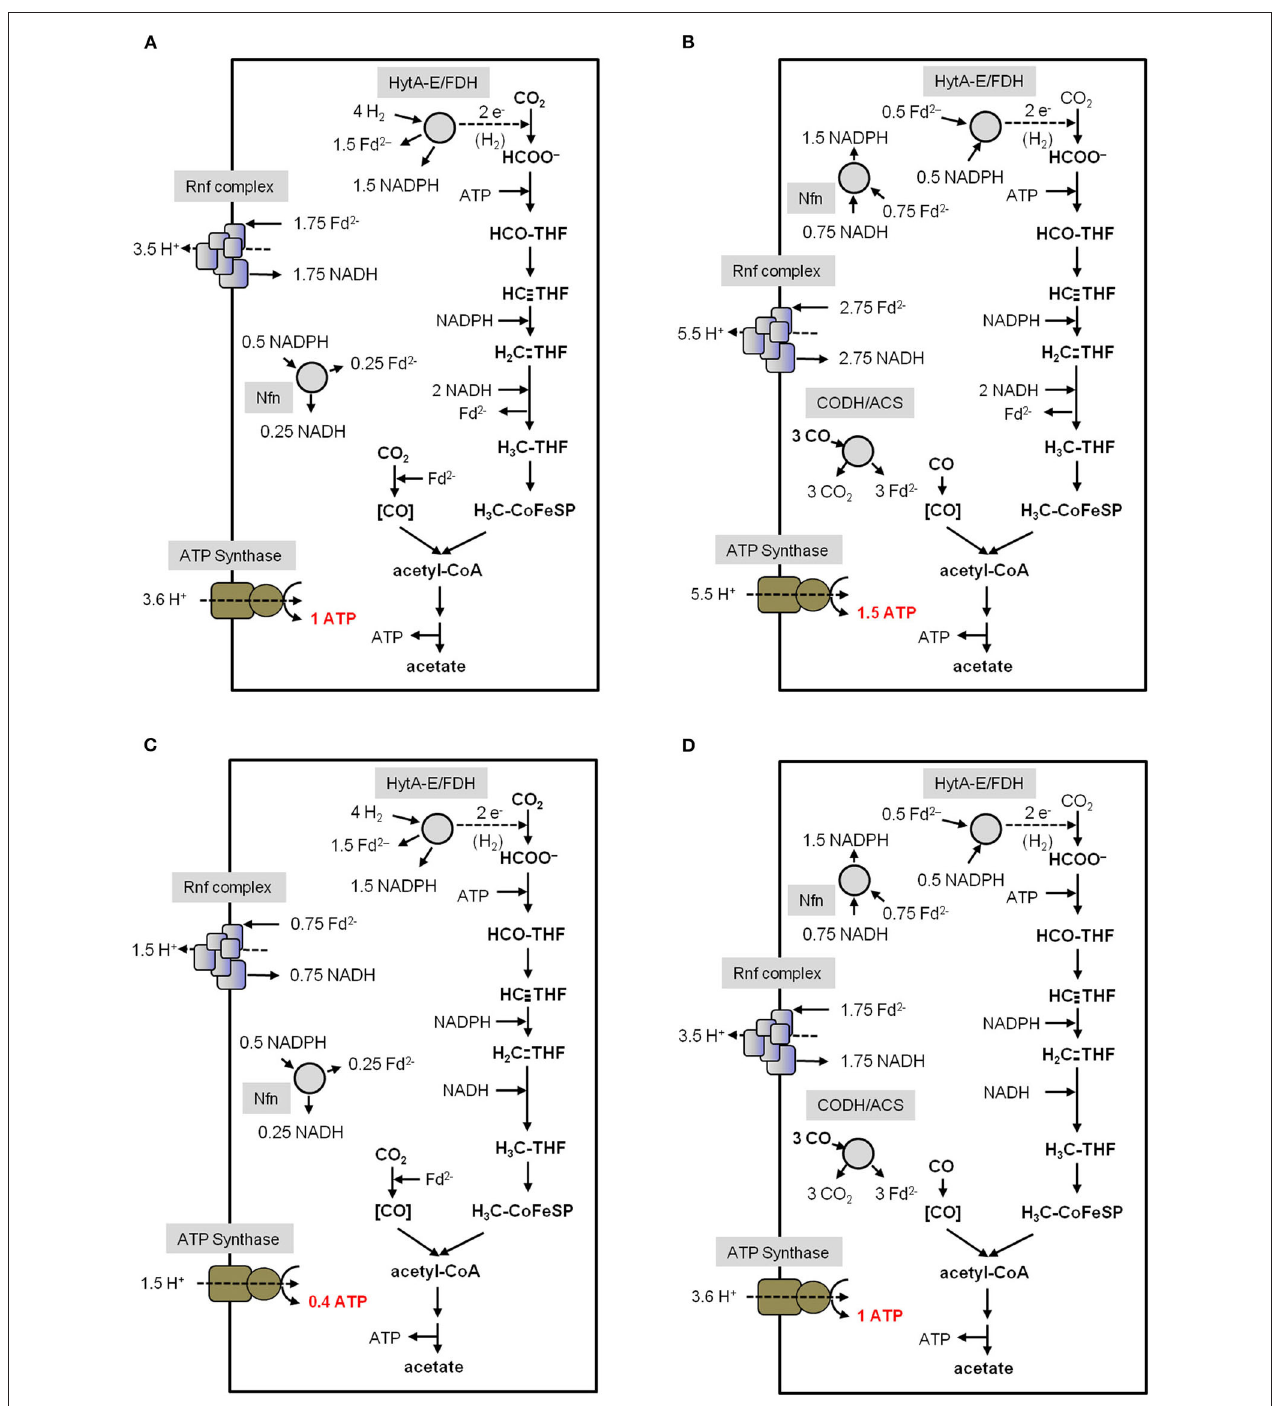
FIGURE 5 | Bioenergetics of acetate formation from H 2 + CO 2 and CO in C. autoethanogenum. The reducing equivalents for the reductive steps in the WLP (A,C) are provided by an H 2 -oxidizing, electron-bifurcating hydrogenase/formate dehydrogenase complex (HytA-E/FDH) which reduces Fd, NADP + and CO 2 . The reducing equivalents for the reductive steps during CO oxidation (B,D) are provided by the CO-oxidizing CODH/ACS which reduces Fd. The Nfn complex is transferring electrons between Fd, NADH and NADPH. The methylene-THF reductase is assumed to be electron bifurcating in (A,B) . In (C,D) the methylene-THF reductase is not electron bifurcating. Excess Fd 2 − is oxidized by the Rnf complex which reduces NAD + and builds up a H + gradient. This gradient drives ATP synthesis via the H + -dependent ATP synthase. In total, 0.4/1 ATP from H 2 + CO 2 and 1/1.5 ATP from CO (depending on the MTHFR reaction) can be synthesized per acetate produced. CODH/ACS, CO dehydrogenase/acetyl coenzyme A synthase; THF, tetrahydrofolic acid; Nfn, electron-bifurcating and ferredoxin-dependent transhydrogenase.